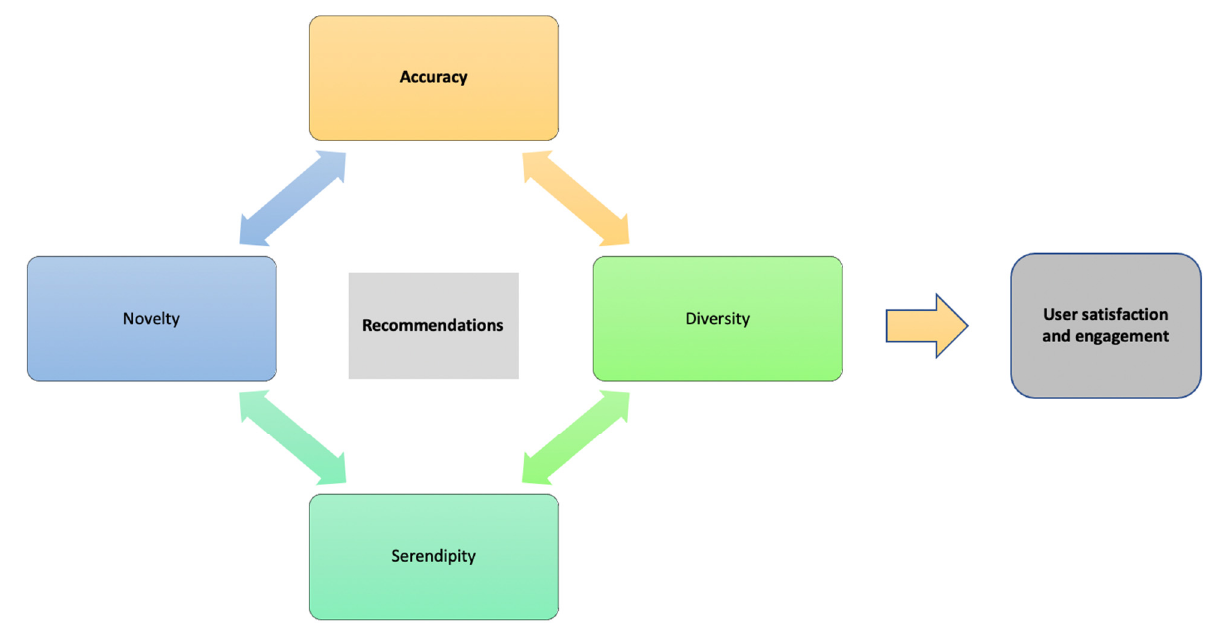
Figure 4. Parameters to evaluate the quality of news recommendations.